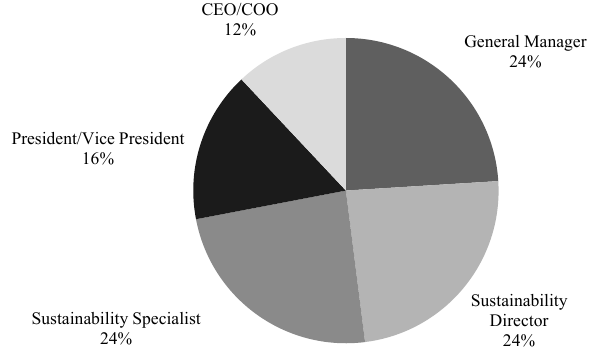
Figure 1. Sample description: professional position.